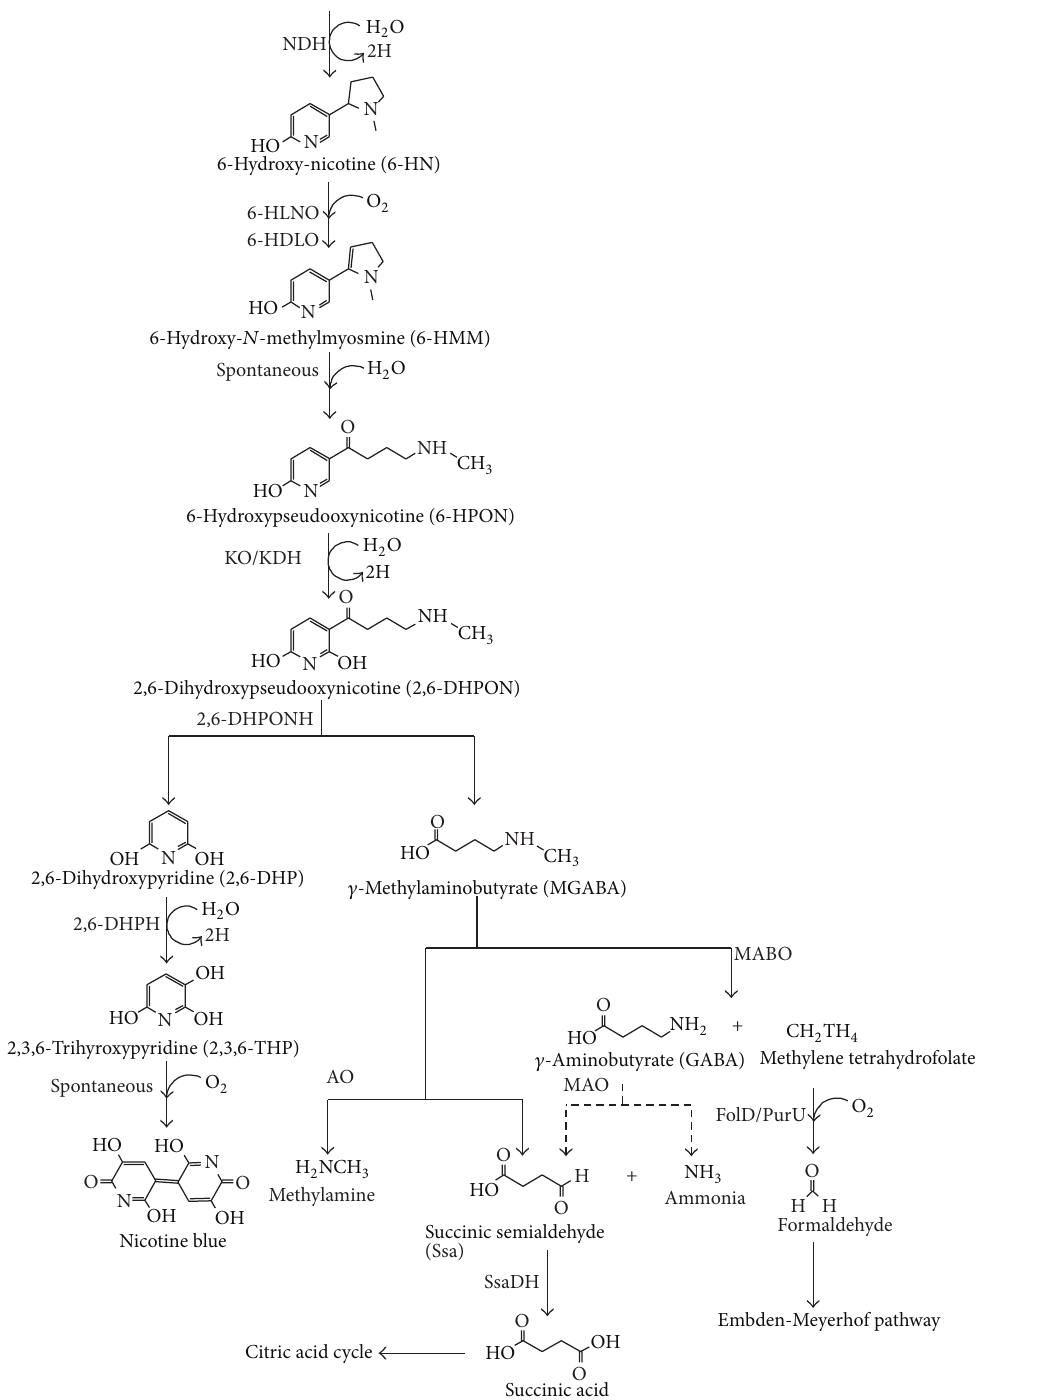
Figure 1: The pyridine pathway of nicotine degradation by A. nicotinovorans and Nocardioides sp. NDH, nicotine dehydrogenase; 6-HLNO, 6-hydroxy-L-nicotine oxidase; 6HDNO, 6-hydroxy-D-nicotine oxidase; KO, ketone oxidase; KDH, ketone dehydrogenase; 2,6-DHPONH, 2-6-dihyroxypseudooxynicotine hydrolase; 2,6-DHPH, 2,6-dihydroxypyridine-3-hydroxylase; MABO, 𝛾 - N -methylaminobutyrate oxidase; MAO, monoamine oxidase; AO, amine oxidase; FolD, methylenetetrahydrofolate dehydrogenase/cyclohydrolase; PurU, formyltetrahydrofo- late deformylase; SsaDH, succinic semialdehyde